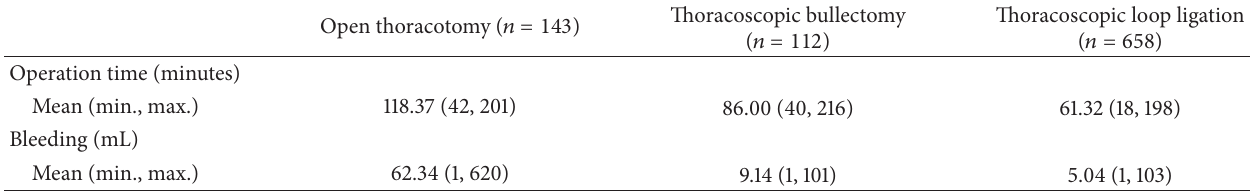
Table 2: Mean operating time and the blood loss during each of the 3 operating procedures.